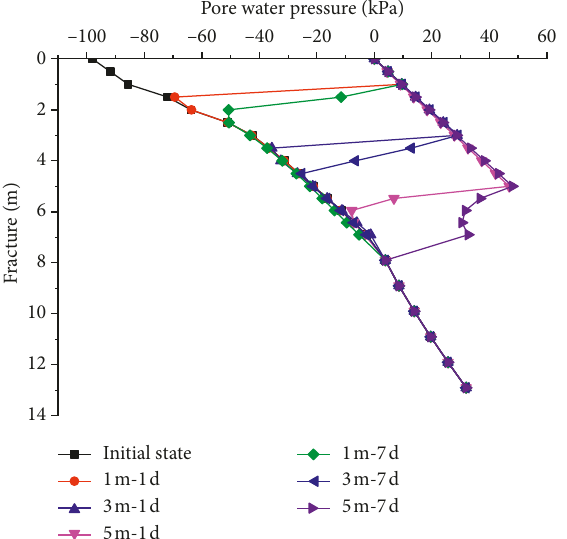
Figure 7: Distribution curves of pore water pressure with depth in different fracture permeability coefficient ratios ( x � 15m). Figure 5: Distribution curves of pore water pressure with depth in